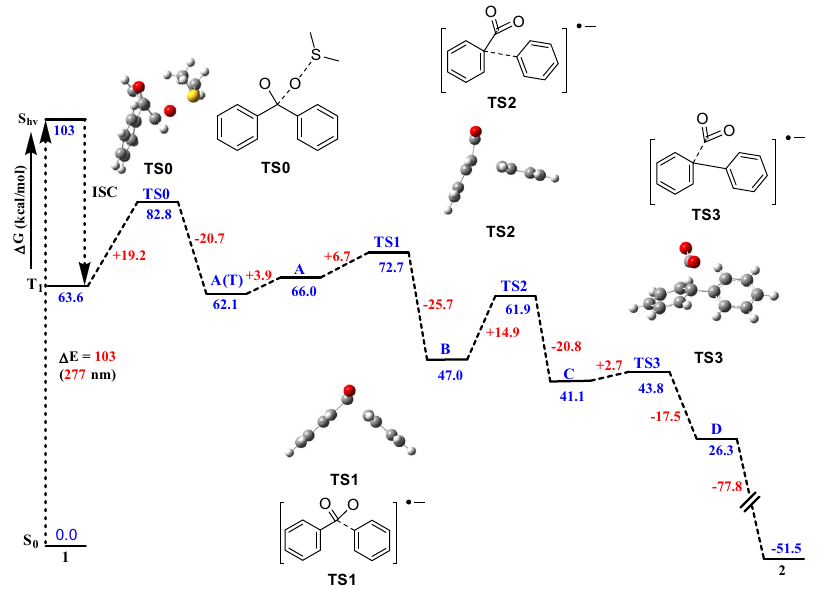
Fig. 5 DFT calculation. B3LYP/6-31 + + G(d,p) free energy pro fi le of the reaction.